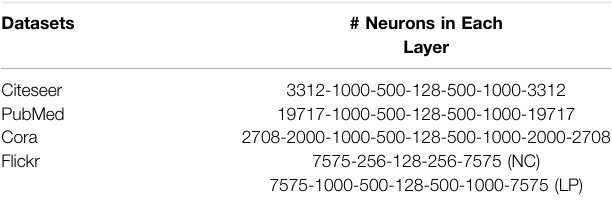
TABLE 5 | Detailed architecture information for datasets ( DANRL-CA- CSM/LPA ). Datasets